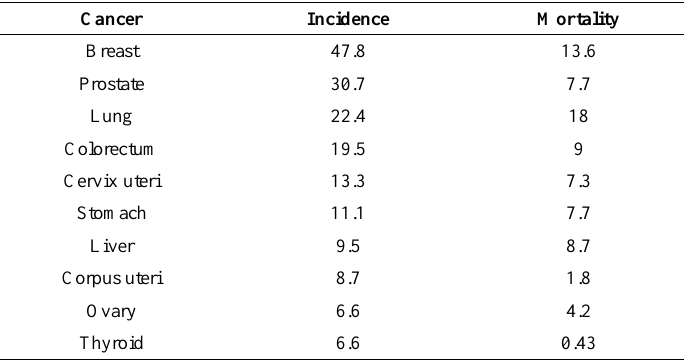
Table 1. Estimated age-standardized incidence and mortality rates in 2020, worldwide, both sexes, all ages